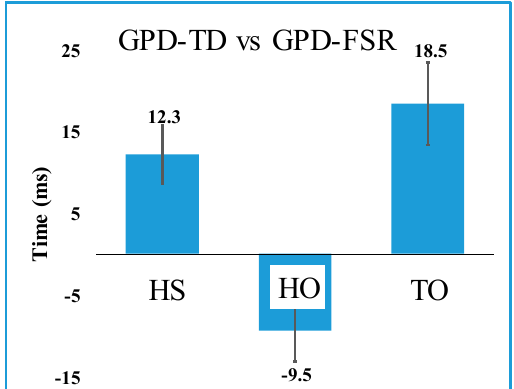
Figure 3. Mean error (± Std) of heel strike (HS), heel-off (HO) and toe-off (TO) for gait phase detection of typically developing children (GPD-TD) relative to gait phase detection via force sensing resistors (GPD-FSR). HS corresponds to loading response, HO corresponds to terminal stance and TO corresponds to initial swing.